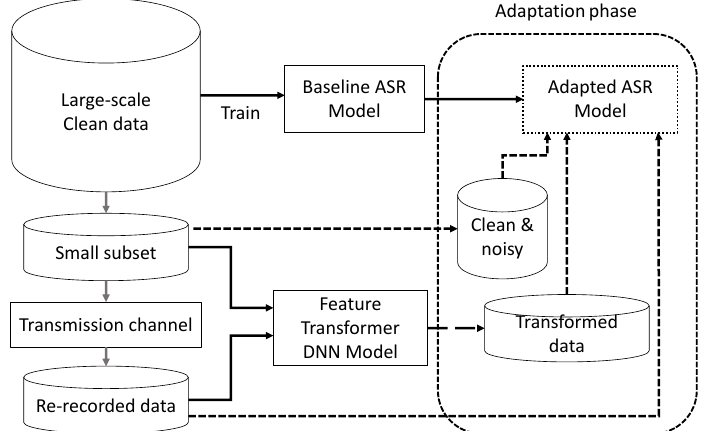
Figure 5. DNN-based data augmentation and adaptation of ASR